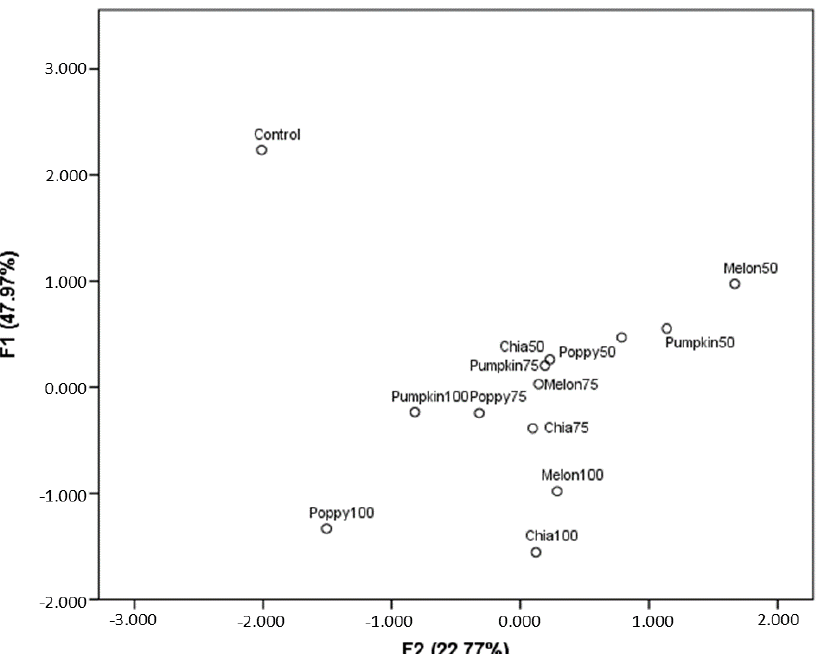
Figure 2. Principal component analysis (PCA) of different parameters in fuet samples. Color (L*, a*, b*, C*, h*) and texture (hardness, stickiness, cohesiveness, springiness, chewiness) parameters, fatty acid composition (palmitic acid, stearic acid, oleic acid, linoleic acid, and linolenic acid) and nutrition evaluation values (content of protein, ashes, crude fat, total carbohydrates, and energy value) are included. F1: L* (0.082), a* ( − 0.791), b* ( − 0.734), C* ( − 0.822), h* ( − 0.153), protein ( − 0.205), ashes ( − 0.694), crude fat (0.866), total carbohydrates (-0.888), energy value (0.866), palmitic (0.942), stearic (0.898), oleic (0.865), linoleic ( − 0.555), linolenic ( − 0.436), harness (0.781), stickiness ( − 0.408), cohesiveness (0.531), springiness ( − 0.167), chewiness (0.942). F2: L* (0.630), a* (0.075), b* (0.552), C* (0.212), h* (0.757), protein ( − 0.790), ashes ( − 0.504), crude fat (0.426), total carbohydrates (0.077), energy value (0.441), palmitic (0.201), stearic (0.372), oleic (0.251), linoleic ( − 0.356), linolenic (0.072), harness ( − 0.510), stickiness ( − 0.745), cohesiveness ( − 0.449), springiness (0.752), chewiness ( − 0.108). Table 5. Sensory evaluation of the fuet sausage samples.